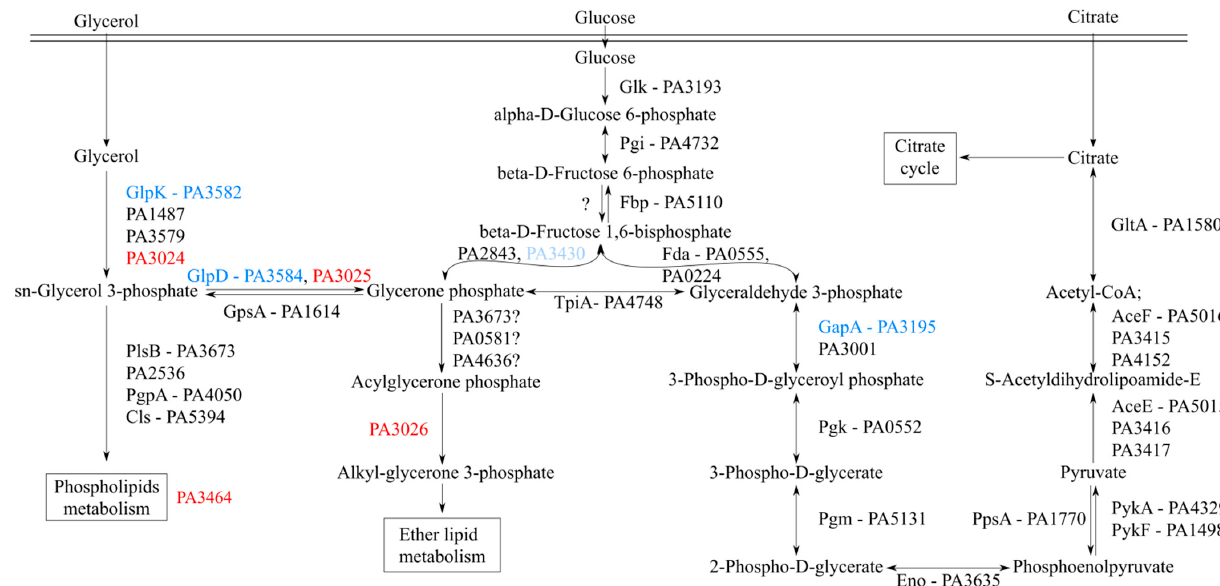
Figure 5. Schematic representation of the part of central carbon metabolism in P. aeruginosa . The pathways were drawn based on the Pseudomonas database [48] and the literature [49–51]. Red and blue indicate increased or decreased gene expression in response to PA3027 overproduction, respectively.